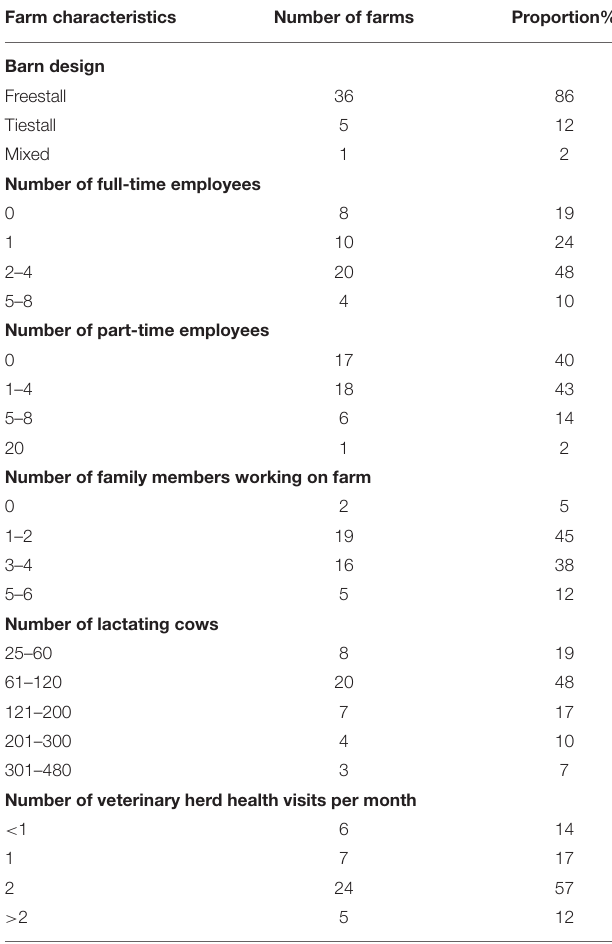
TABLE 1 | Demographic characteristics of the farms represented by participants ( n = 42) in seven focus groups on antimicrobial use on dairy